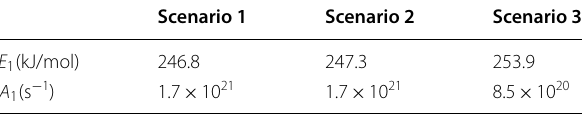
Table 4 Kinetic parameters E 1 and A 1 for different fire